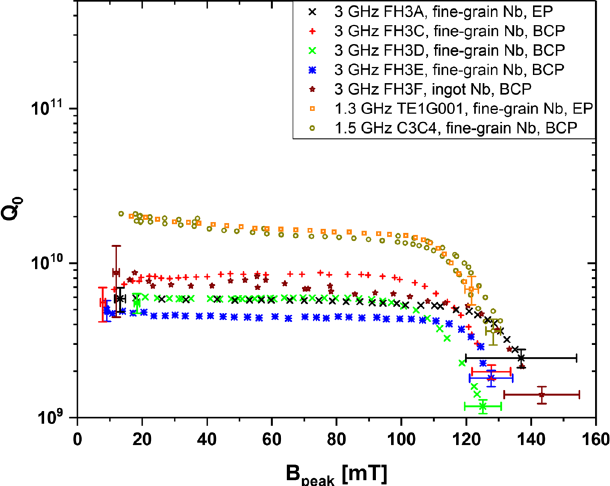
FIG. 11. 3 GHz cavities test results after EP or BCP along with test results for 1.3 GHz and 1.5 GHz single-cell cavities. ¼ 4 . 2 mT = ð MV = m Þ was used for 1.3 GHz (TESLA B p = E acc ¼ 4 . 5 mT = ð MV = m Þ was used for 1.5 GHz end cell); B p = E acc [old Cornell (OC) center cell]. All data is measured at T b ¼ 2 . 0 K. No field emission was observed in any